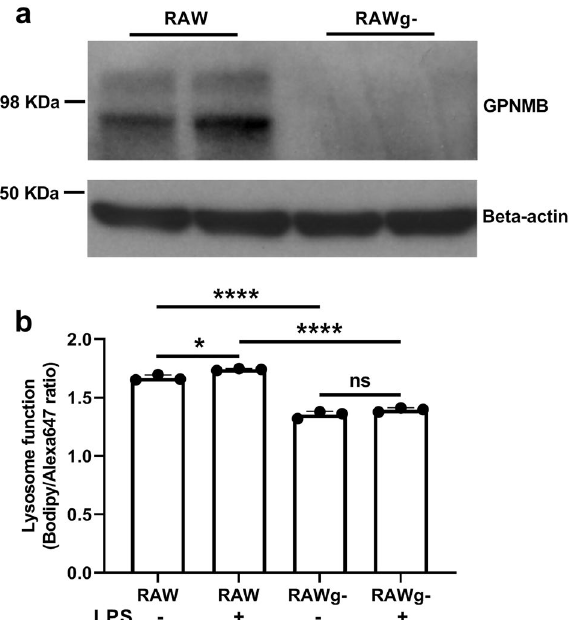
Figure 6. Decreased lysosome function in Gpnmb knockout RAW macrophages. ( a ) GPNMB western blot from lysates of RAW264.7 macrophages and Gpnmb knockout RAW264.7 macrophages. Uncropped blot shown in Supplemental Fig. 5. ( b ) Lysosome function was assessed by 1 h incubation of 2 µg/mL lysosome function indicator with RAW264.7 and Gpnmb knockout RAW264.7 macrophages with or without 24 h pretreatment with 250 ng/mL LPS. Results were illustrated using median fluorescence intensity ratio (*, p < 0.05; ****, p < 0.0001 by ANOVA with Tukey’s posttest). Graph prepared using GraphPad Prism software v9.0.0 (www. graph pad.